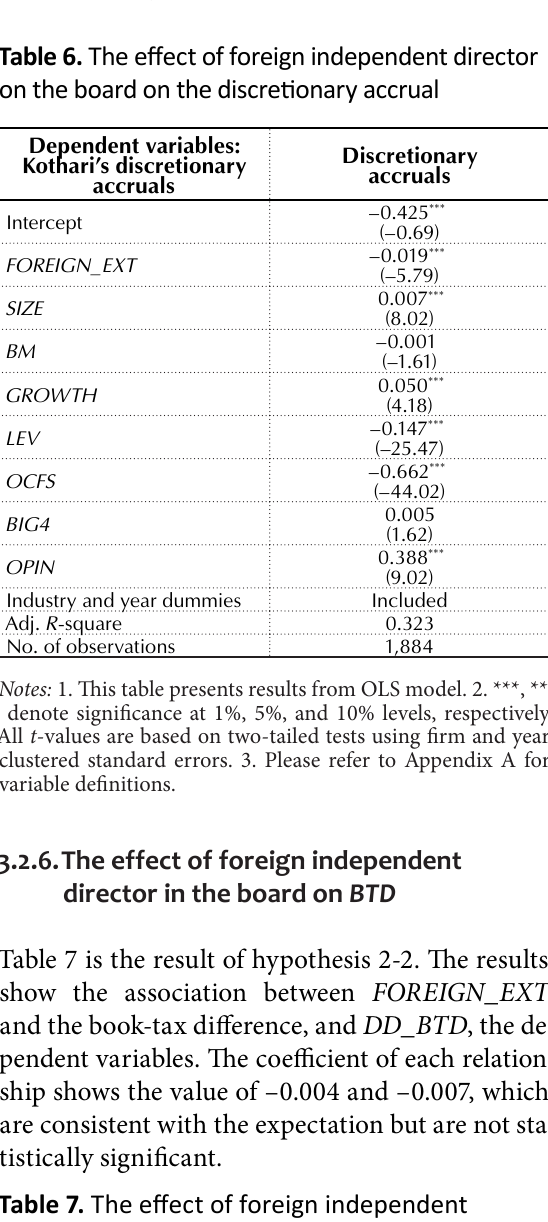
Table 7. The effect of foreign independent